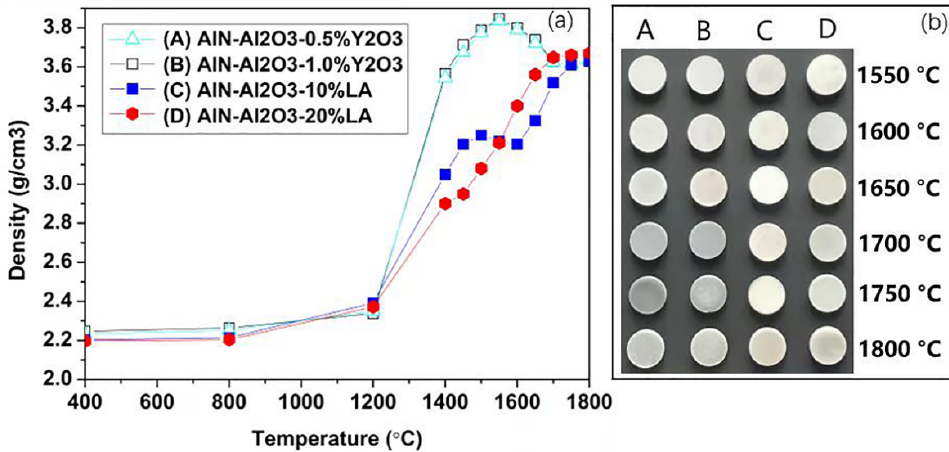
Figure 1. The densities ( a ) and photos ( b ) of the samples that sintered under different